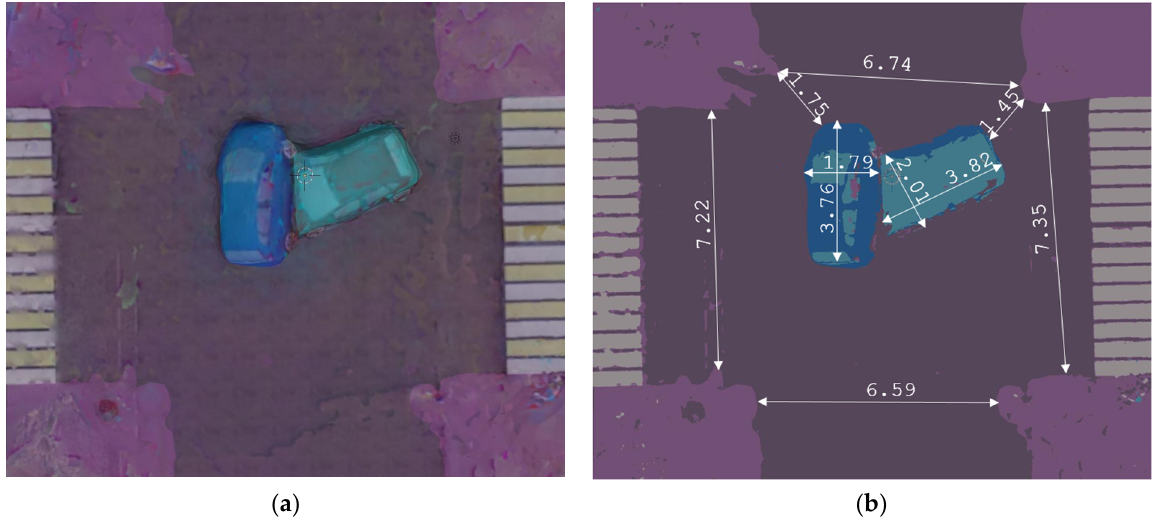
Figure 17. Top view of the 3D scene ( a ); clustered top view with calculated distances between key objects ( b ).